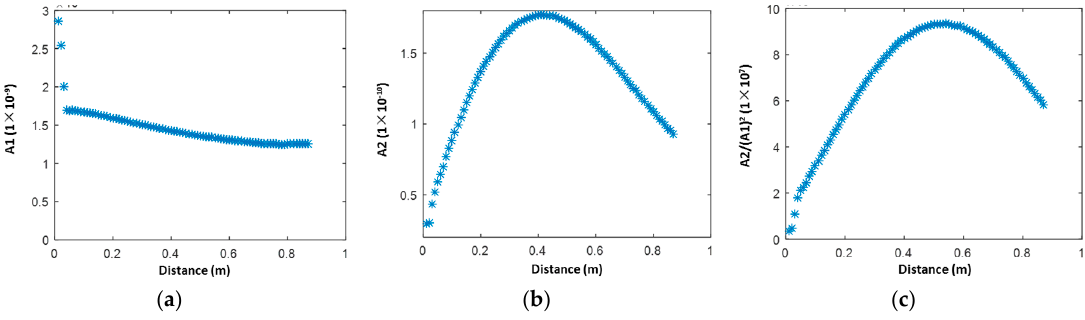
Figure 5. Magnitudes of the S 1 -S 2 mode pair (3.534–7.068 MHz mm) extracted through STFT in the 2-D simulation model ( a ) fundamental mode A1; ( b ) second harmonic mode A2, and ( c ) A2/(A1) 2 .